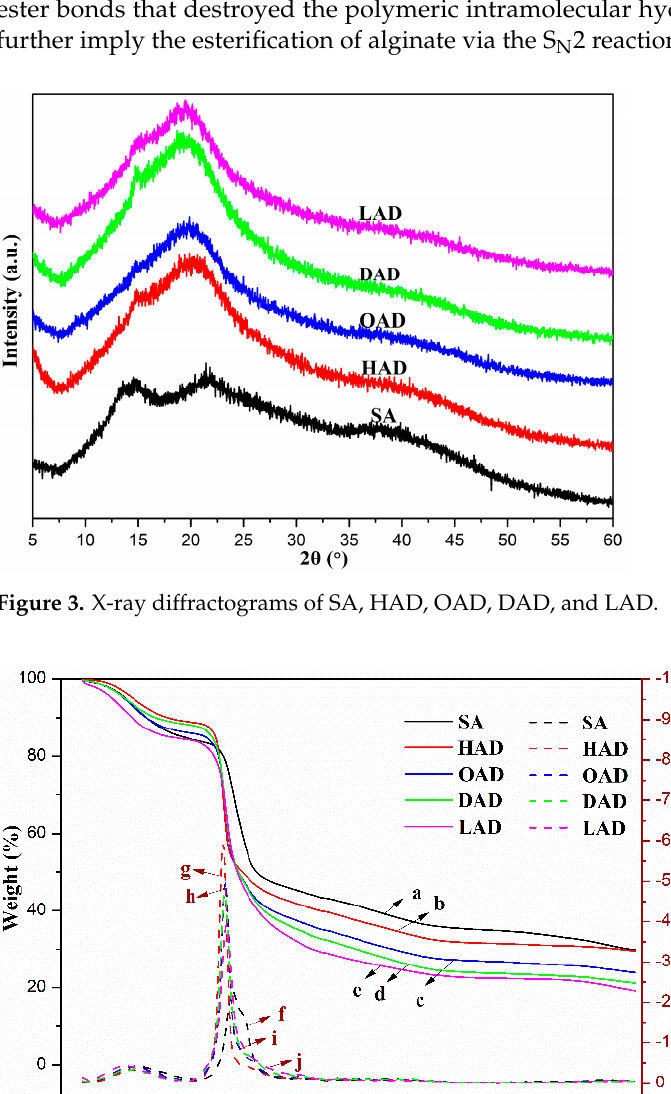
Figure 4. Thermogravimetric analysis of ( a ) SA, ( b ) HAD, ( c ) OAD, ( d ) DAD, and ( e ) LAD as well as